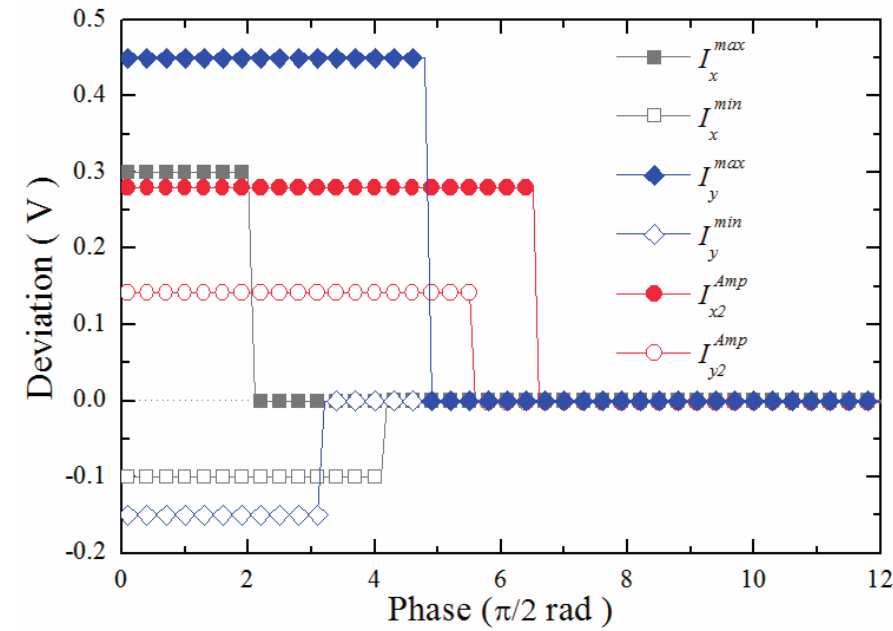
Figure 8. Differences between the parameters obtained using detectors and the ideal